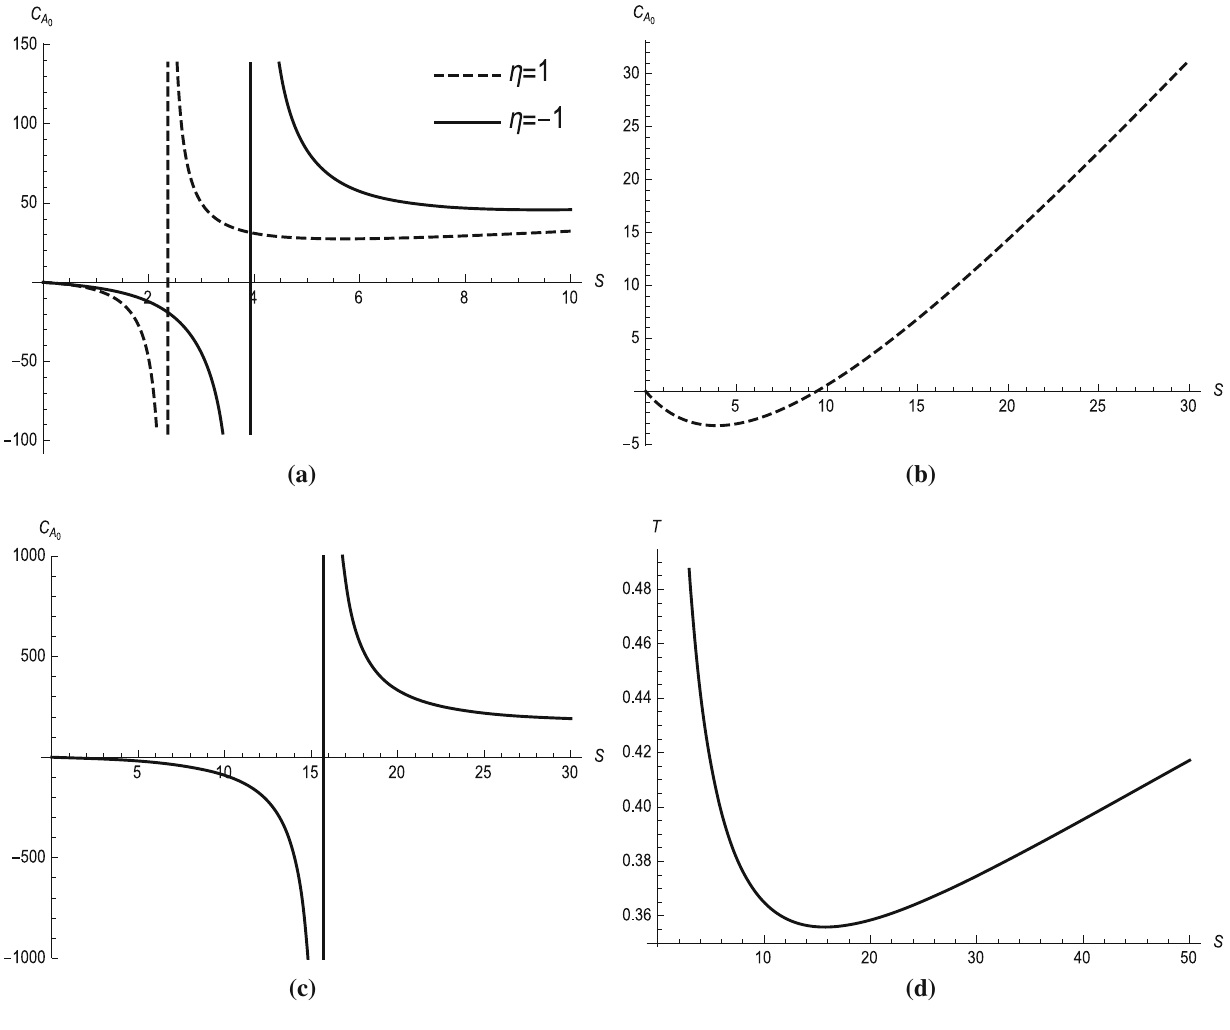
Fig. 1 Specific heat at constant electric potential for a η = 1 , − 1, A 0 = 1 / 2 ,(cid:4) = − 1, b η = 1, A 0 = 2 ,(cid:4) = − 1, c η = − 1, A 0 = 2 ,(cid:4) = − 1 and the Hawking temperature for η = − 1, A 0 = 2 ,(cid:4) = − 1 shown in